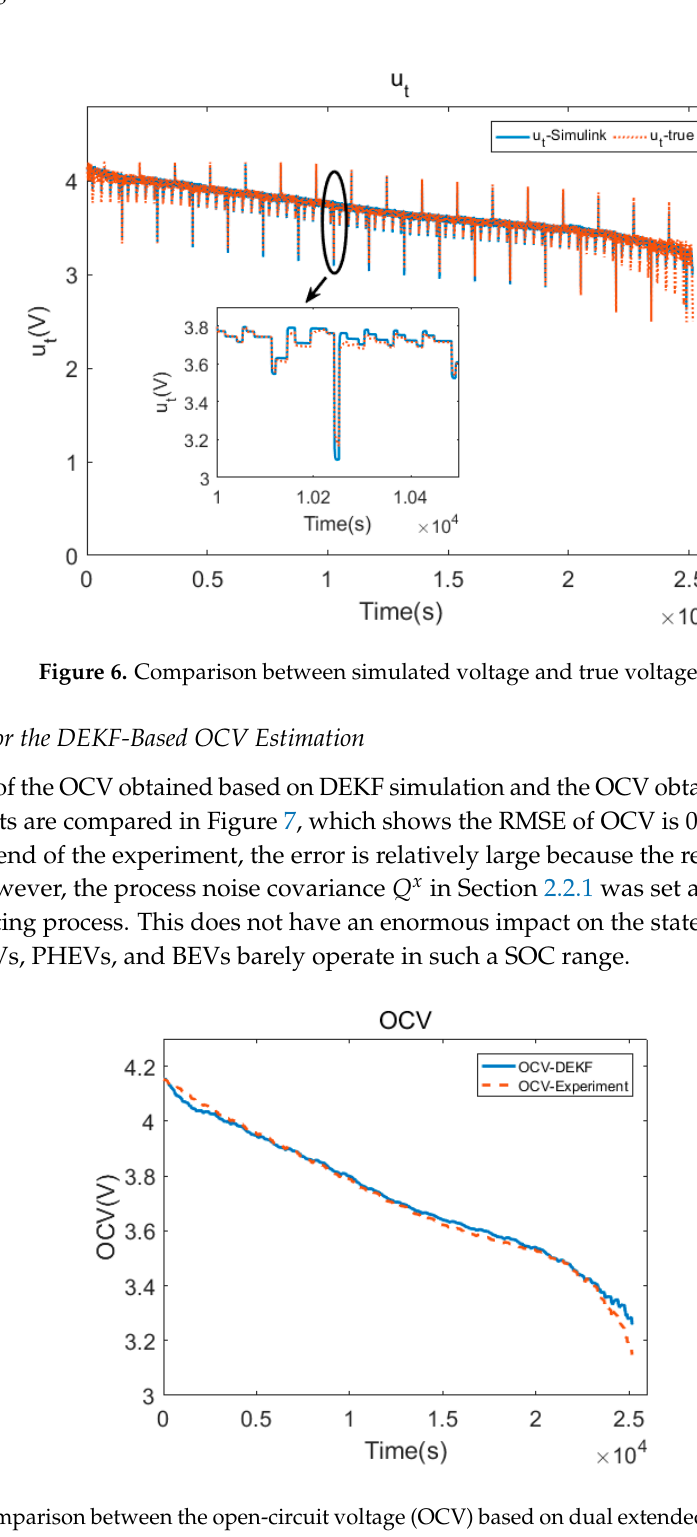
Figure 8. Comparison of SOC-DEKF, SOC-Lookup, and SOC-True. 5.4. Verification of the Peak Power and SOP Estimation In what follows, we assume that (cid:1845)(cid:1841)(cid:1829) (cid:3040)(cid:3036)(cid:3041) = 0.2 and (cid:1845)(cid:1841)(cid:1829) (cid:3040)(cid:3028)(cid:3051) = 0.9 . The peak power estimation result has been plotted in Figure 9a. The orange dotted lines represent the actual power at every sampling point and the blue dotted line and the yellow solid line represent the estimated charge peak power in 10 s and the estimated discharge peak power in 10 s, respectively. Finally, the black circles represent the true peak power in the pulse of 10 s.